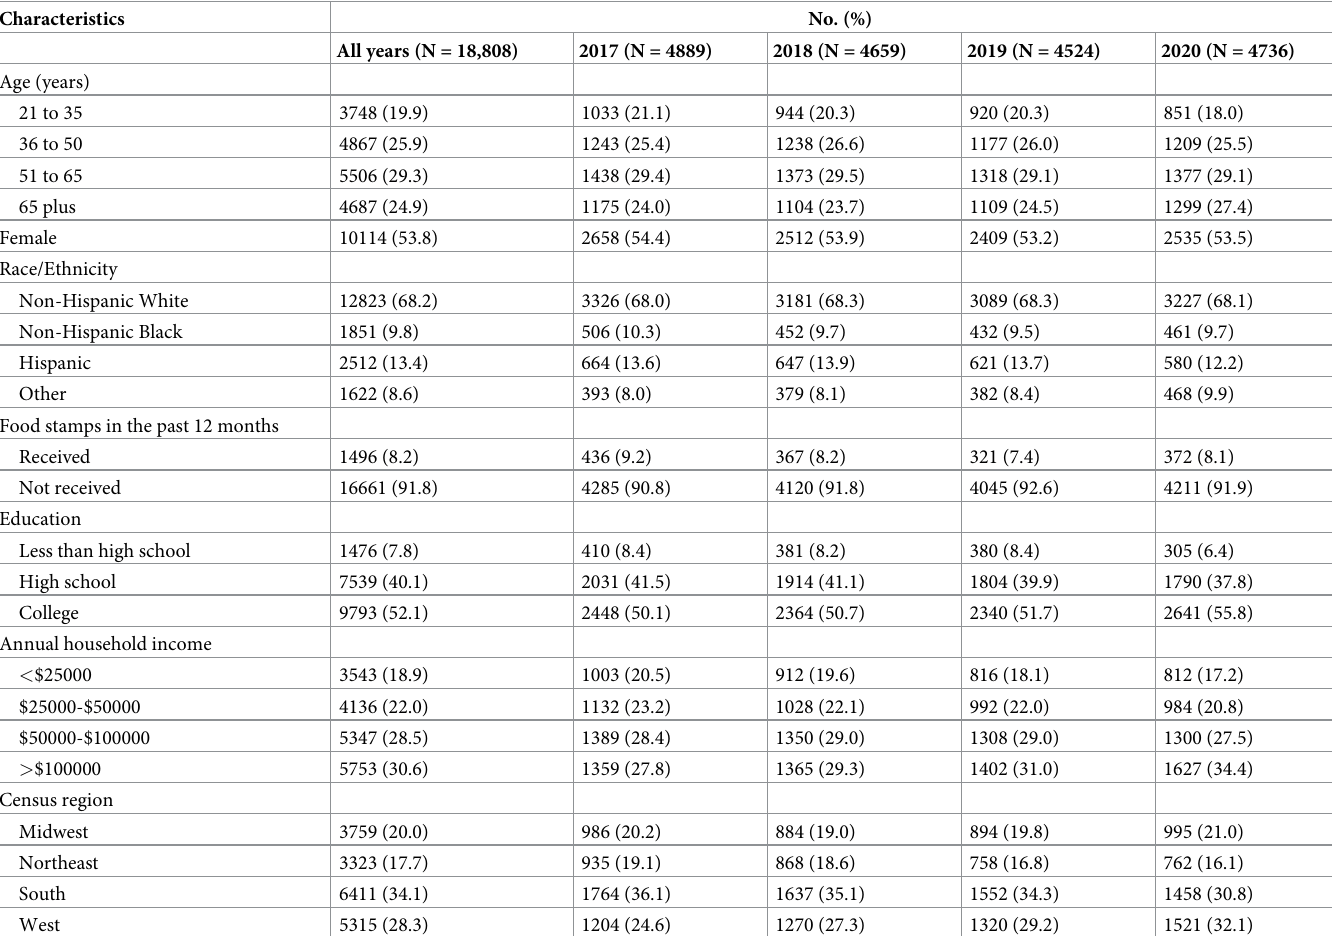
Table 1. Demographic and socio-economic characteristics of the study sample